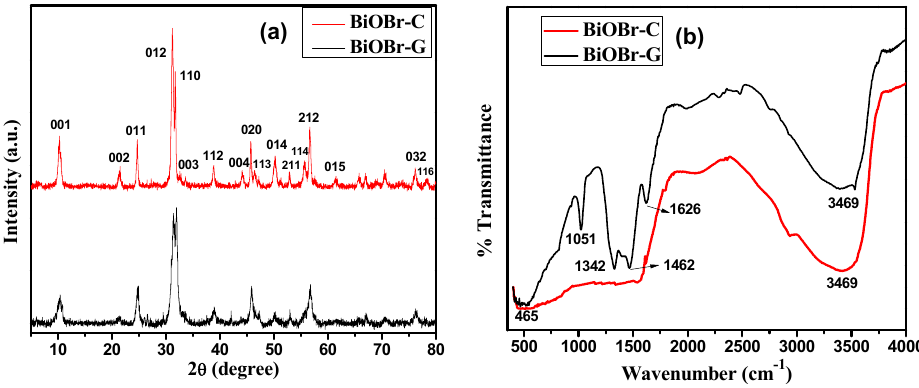
Figure 1. ( a ) XRD patterns; ( b ) FTIR spectra of BiOBr ‐ C and BiOBr ‐ G.